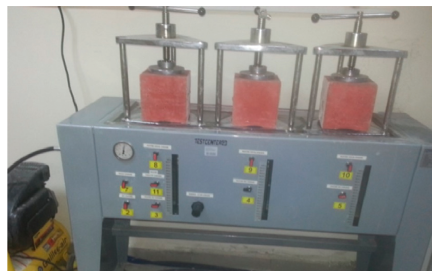
Figure 3: Impermeability test